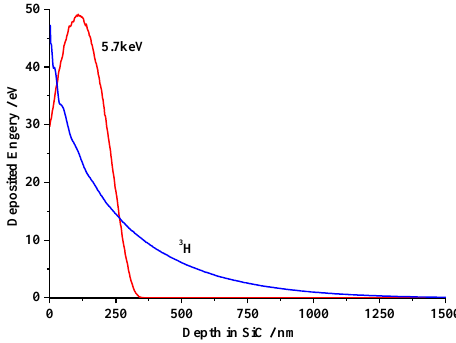
Figure 2. Ionization energy distribution along the material depth direction.